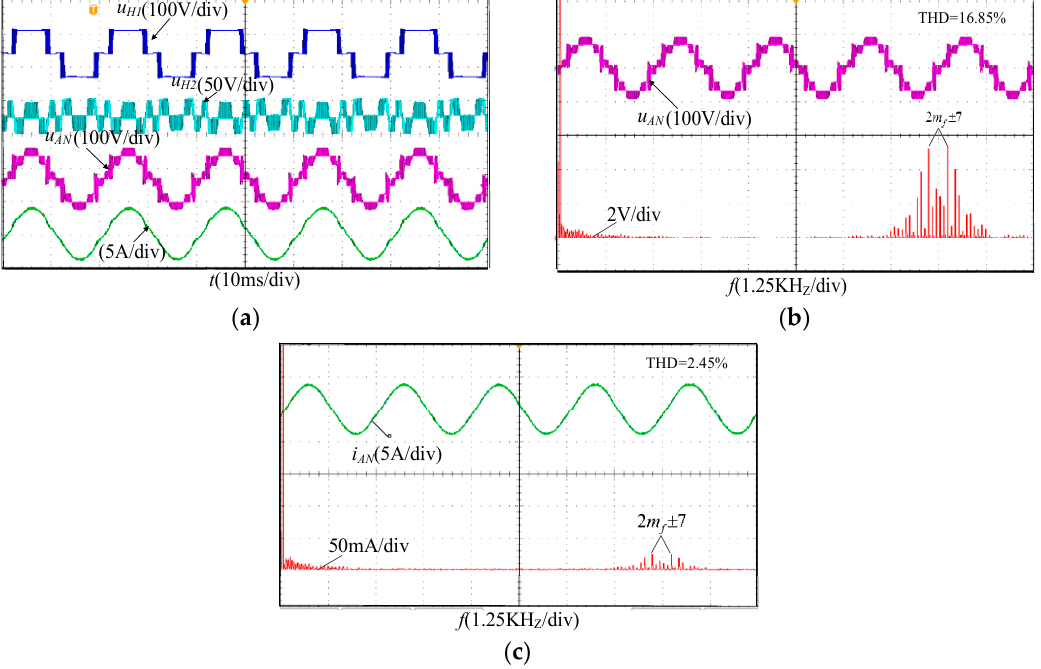
Figure 12. Experimental waveform of HF-PWM. ( a ) Output voltage and current waveform. ( b ) u AN and harmonic spectrum. ( c ) i AN and harmonic spectrum.